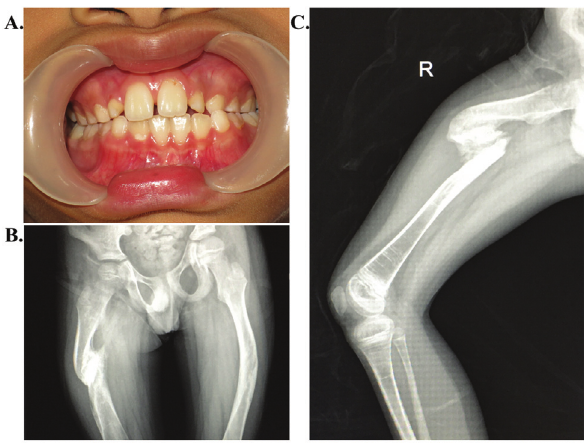
Figure 1 - Clinical and radiographic features of the patient with osteo- genesis imperfecta. (A) Dentinogenesis imperfecta was not present. (B) Standing anteroposterior radiograph of the pelvis and femora showing tilt- ing of the pelvis and varus deformity of both femora. (C) Radiograph of his right femur showing a hypertrophic malunion of the femoral